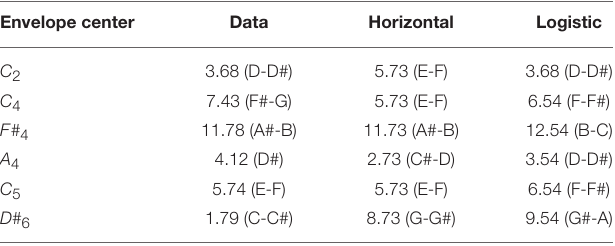
TABLE 1 | Highest Shepard tones in the data predicted by the threshold model using a horizontal and a logistic threshold function for the six envelope centers. Envelope